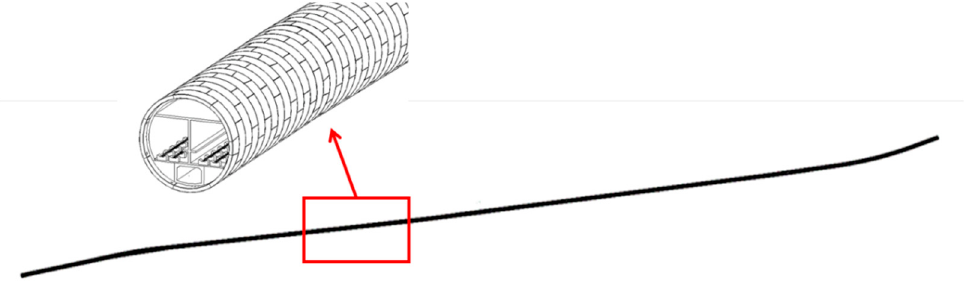
Figure 8. The constructed BIM model for the undersea tunnel project.